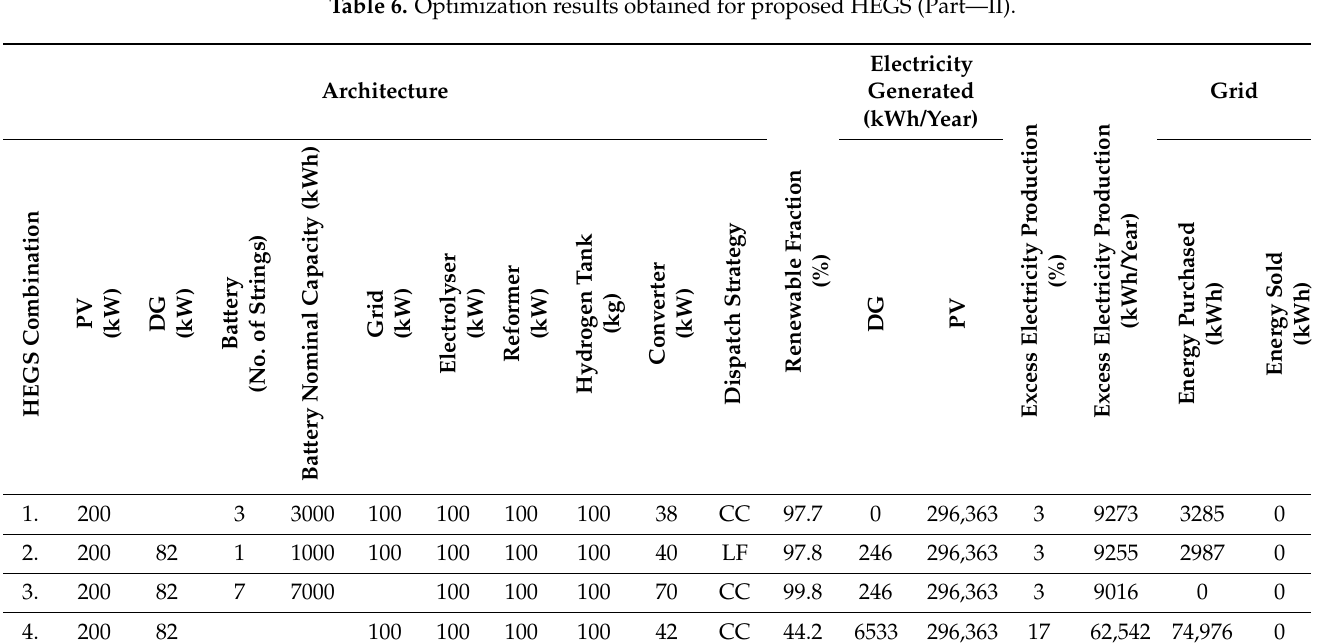
Figure 13. Comparison of cost of energy & cost of hydrogen for selected HEGS combination. Table 6. Optimization results obtained for proposed HEGS